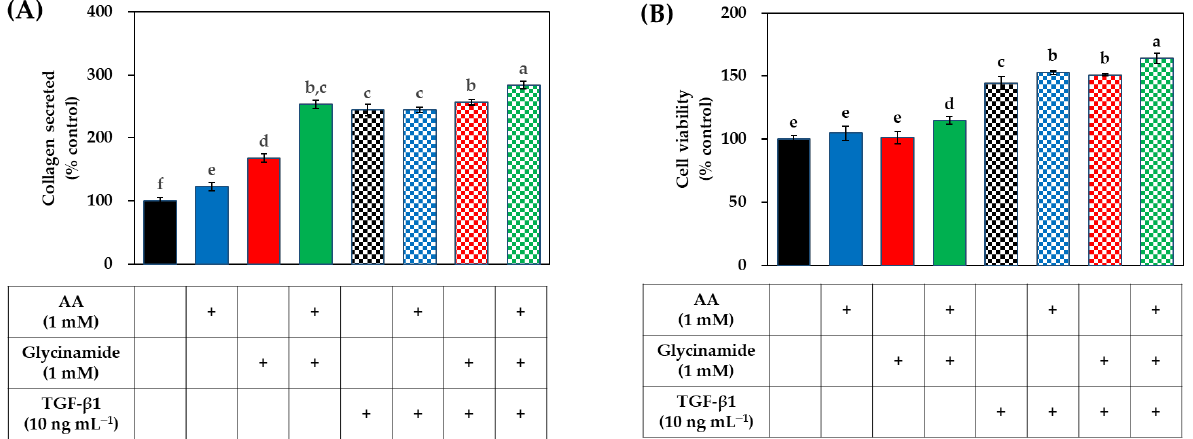
Figure 5. Effects of individual and combined treatments of AA, glycinamide, and transforming growth factor (TGF)- β 1 on the collagen production in HDFs. Cells were treated with AA, glycinamide, or TGF- β1 each or in combinations. After 48 h, the collagen protein secreted into the conditioned medium ( A ) and the viability of the adherent cells ( B ) were determined. Data are presented as % of control (means ± SD, n = 3 for ( A ), and n = 5 for ( B )). Groups that share the same alphabet letters (a – f) do not have significantly different means at the p < 0.05 level.